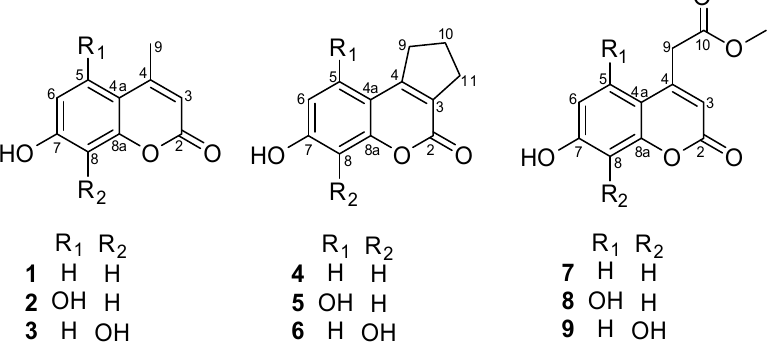
Figure 1. Chemical structures of coumarins used as substrates in biotransformation through Cunninghamella elegans ATCC 10028b and Aspergillus brasiliensis ATCC 16404.